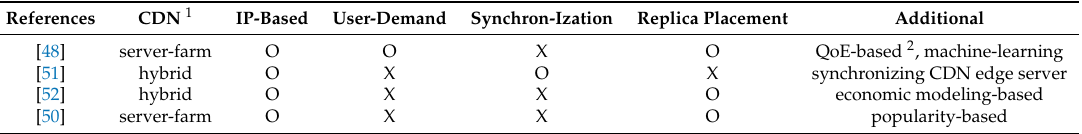
Figure 2. The concept of content distributed network. ( a ) The procedure of current content request; ( b ) The procedure of content-distributed network. Table 3. Comparison of service-oriented network